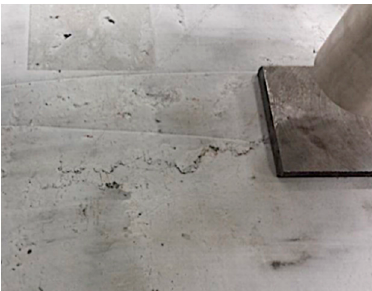
Figure 17. Compression zone of the damaged C-REF + fiber-reinforced concrete with steel fibers (F-RCS) slab element.